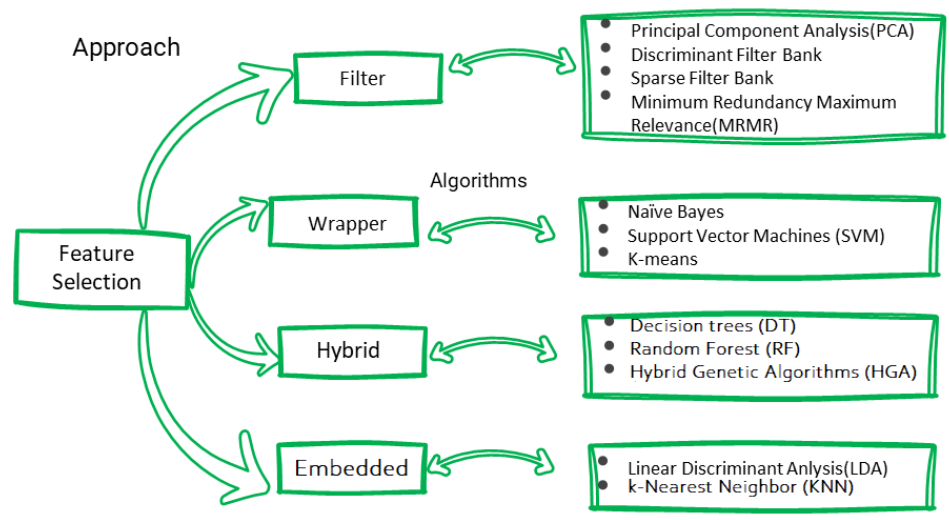
Figure 8. Feature selection